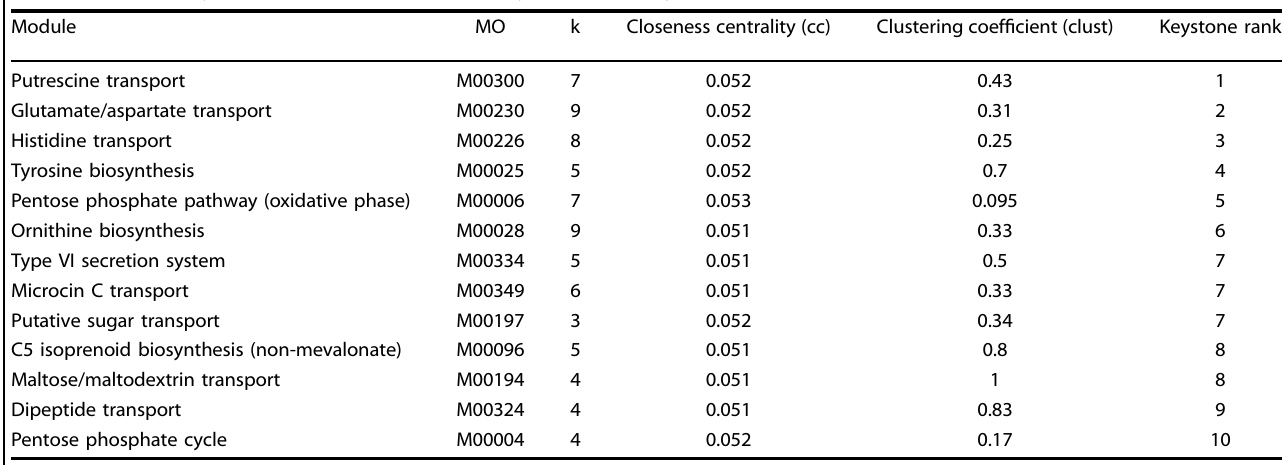
Table 2. Predicted keystoneness of KEGG module pathways from CF